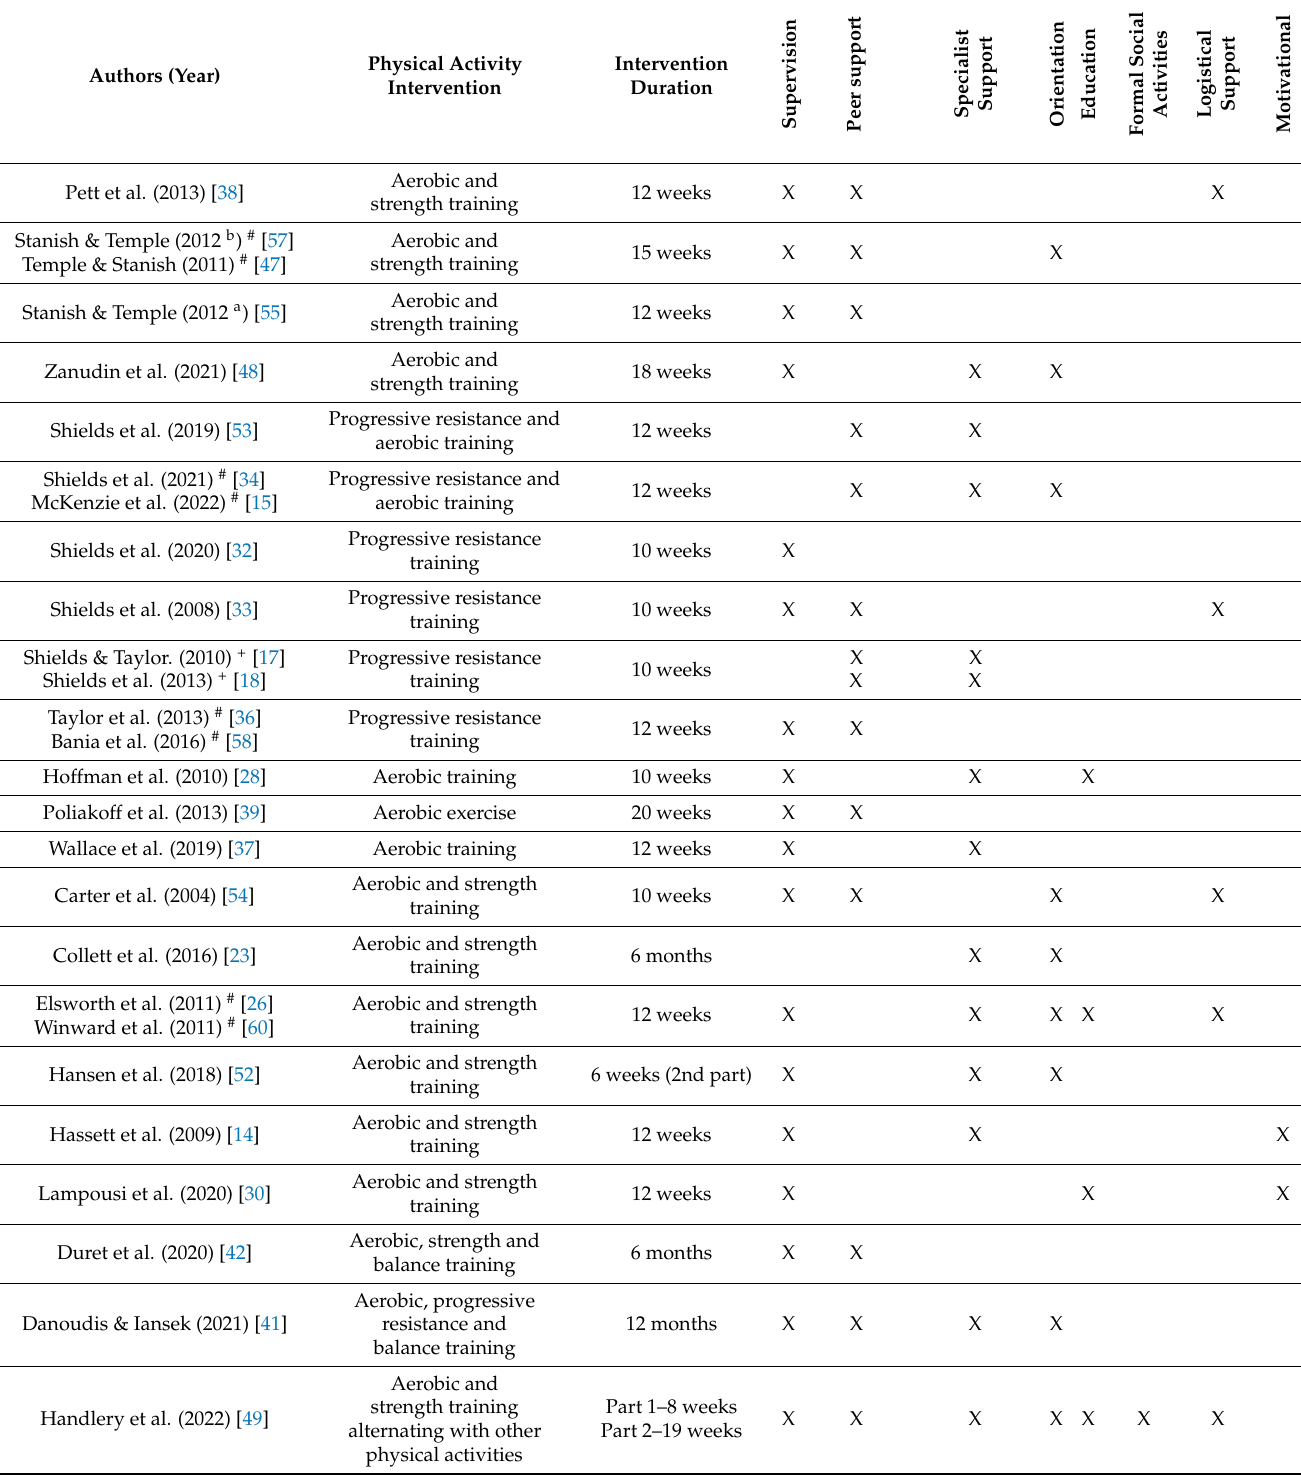
Table 2. Summary of physical activity interventions, intervention duration and social support